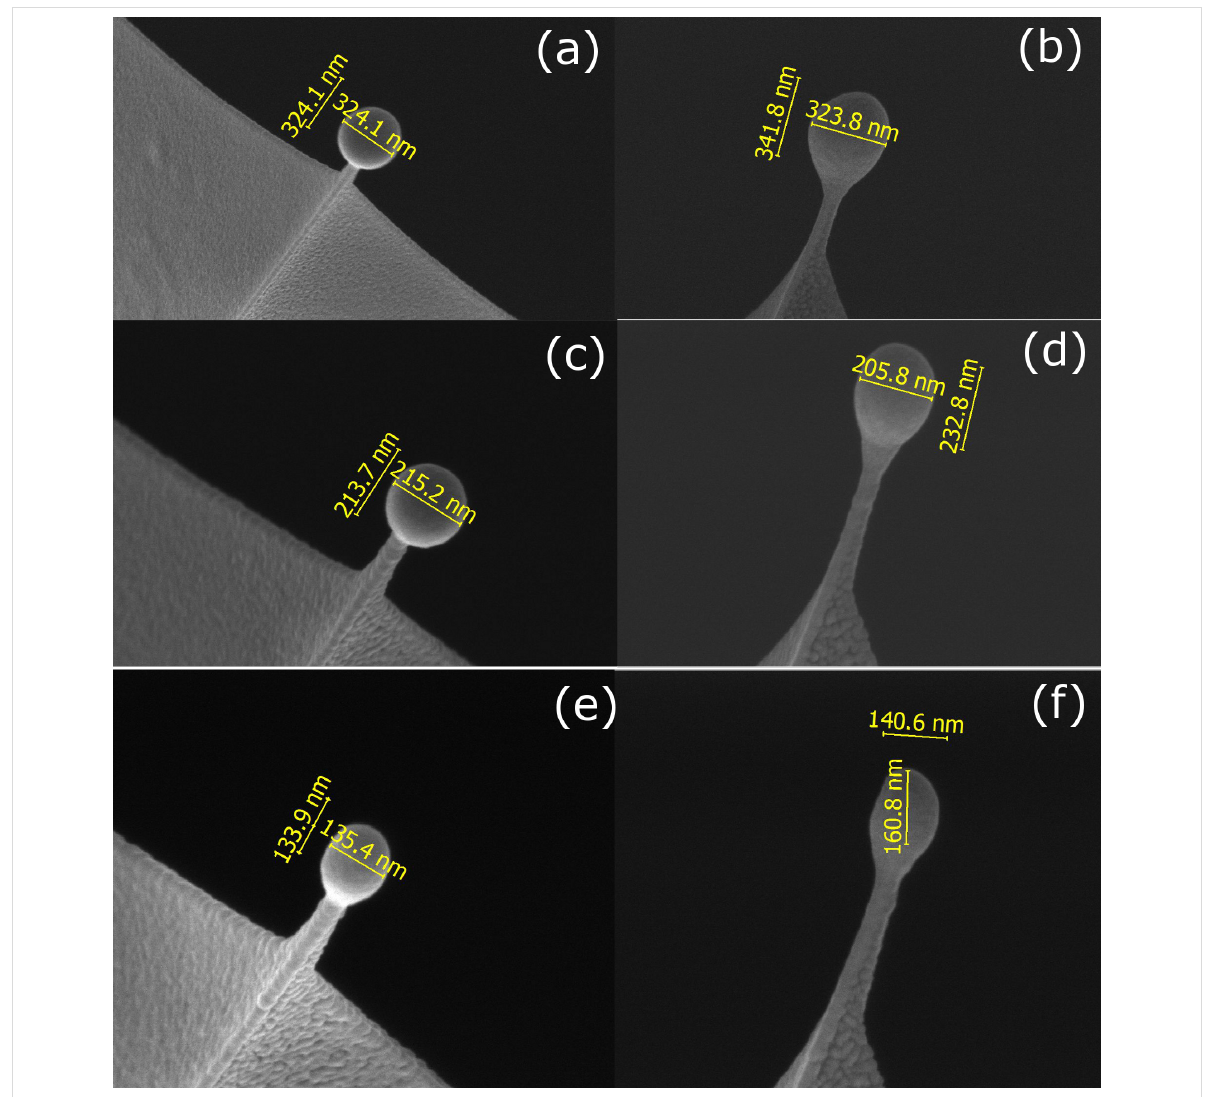
Figure 1: SEM micrographs showing the dimensions of the grown cobalt nanospheres. Top view and front view of cobalt nanospheres of 325 nm (a,b), 215 nm (c,d) and 135 nm (e,f) in diameter.